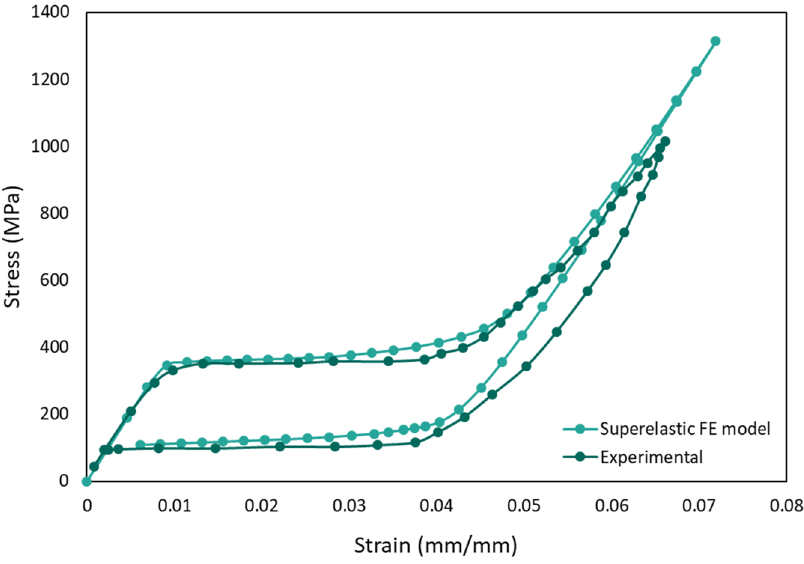
Figure 11. Validation of superelasticity model with actual experiment by Jiang and Li [95].